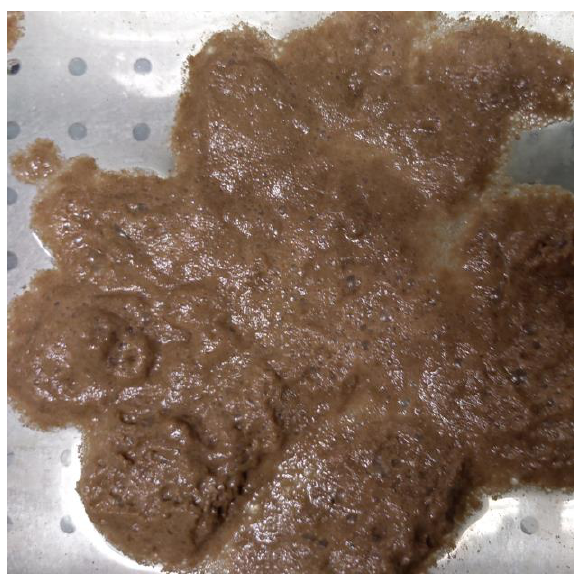
Fig. 5. The photograph was taken before ultrasonic cavitation.